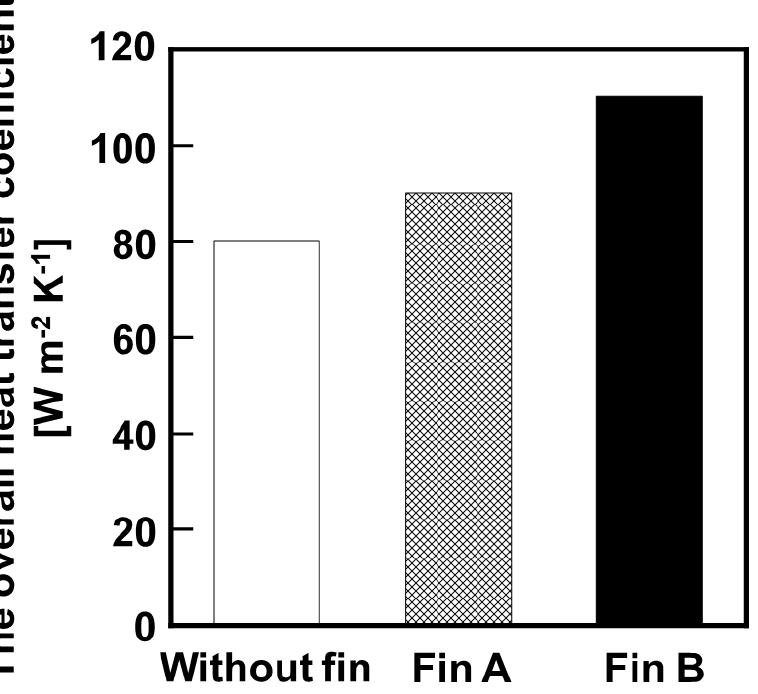
Figure 8. Comparison of the overall heat transfer coefficient using different structure of heat conductive fins.